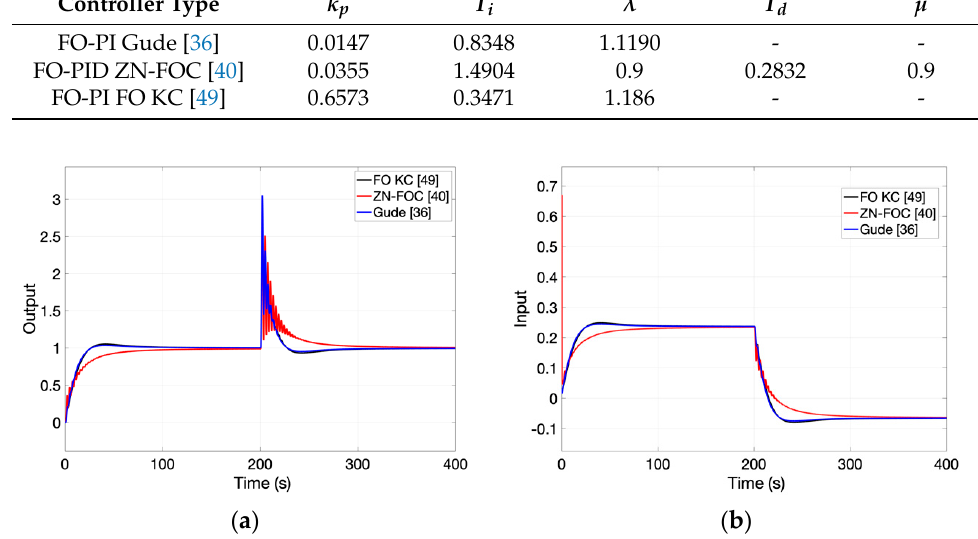
Figure 18. ( a ) Output signals for FO-PID control of the poorly damped process. ( b ) Input signals for FO-PID control of poorly damped process. Controllers tuned according to [36,40,49]. Table 11. Closed-loop results obtained with the FO-PID controller for the poorly damped process.